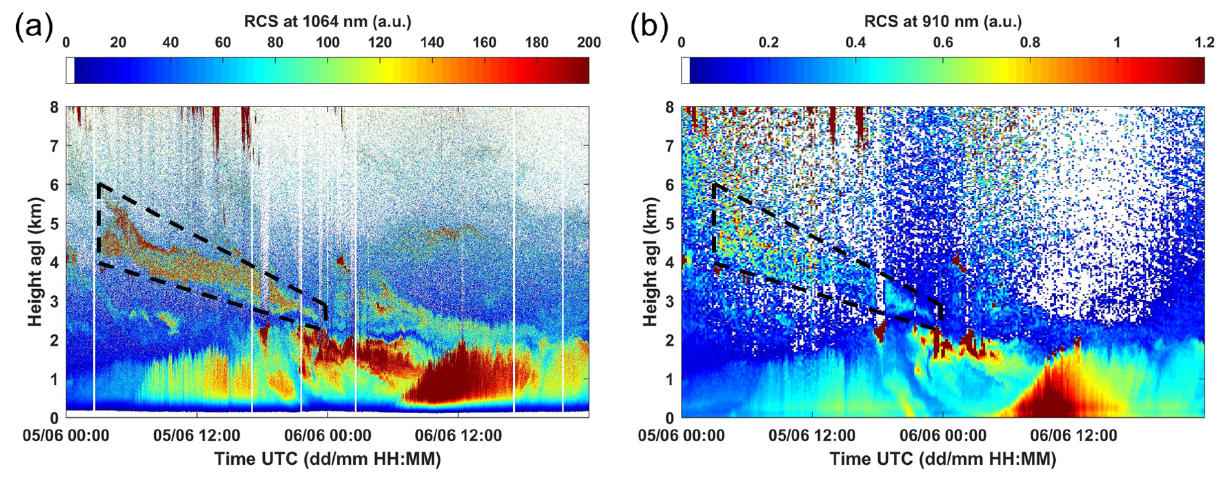
Figure 2. Time–height cross section of range-corrected signal (RCS) (a) at 1064nm of Polly XT and (b) at 910nm of the CL51 ceilometer on 5 and 6 June 2019 over Vehmasmäki station. Time is given in UTC, and height is above ground. Initial Polly XT data were used with temporal and vertical resolutions of 30s and 7.5m, respectively. CL51 data were smoothed with temporal and vertical resolutions of 10min and 70m, respectively. The SPoI (smoke plume of interest) is inside the black box with dashed lines.